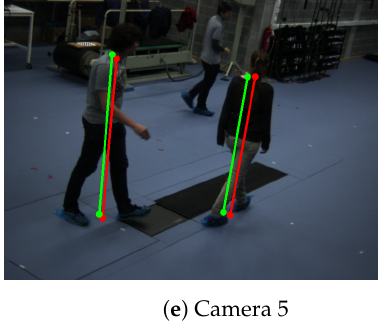
Figure 8. Example of detected the bottom and top positions of the pedestrians of Camera Network 4—single person in an empty room. Red color represents detected positions by the human pose estimation method. Green color represents the detected reprojected positions.